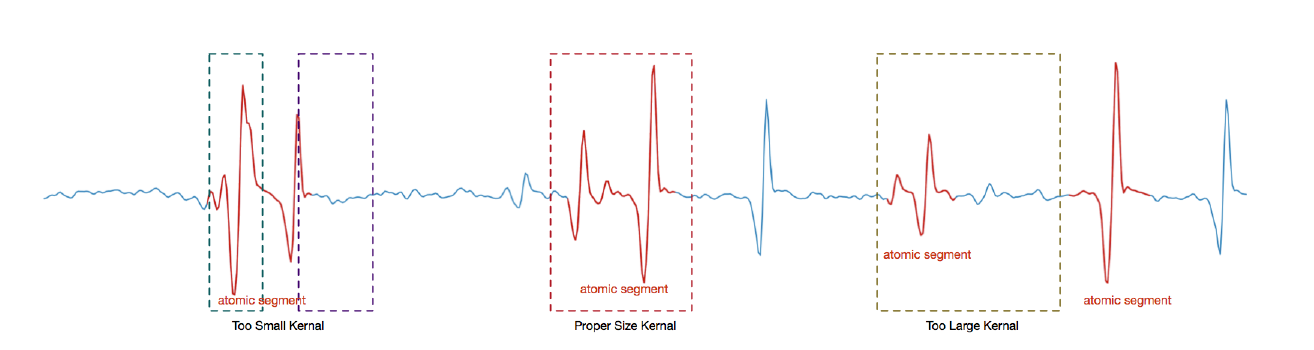
Figure 6. The atomic segment is defined as the shortest time sequence in which sEMG can express effective information. When the convolutional kernel is too small, it is difficult to obtain effective information. If the convolutional kernel is too large, it will contain redundant information, which increases the difficulty for the network to learn efficient information and increase the number of network parameters.